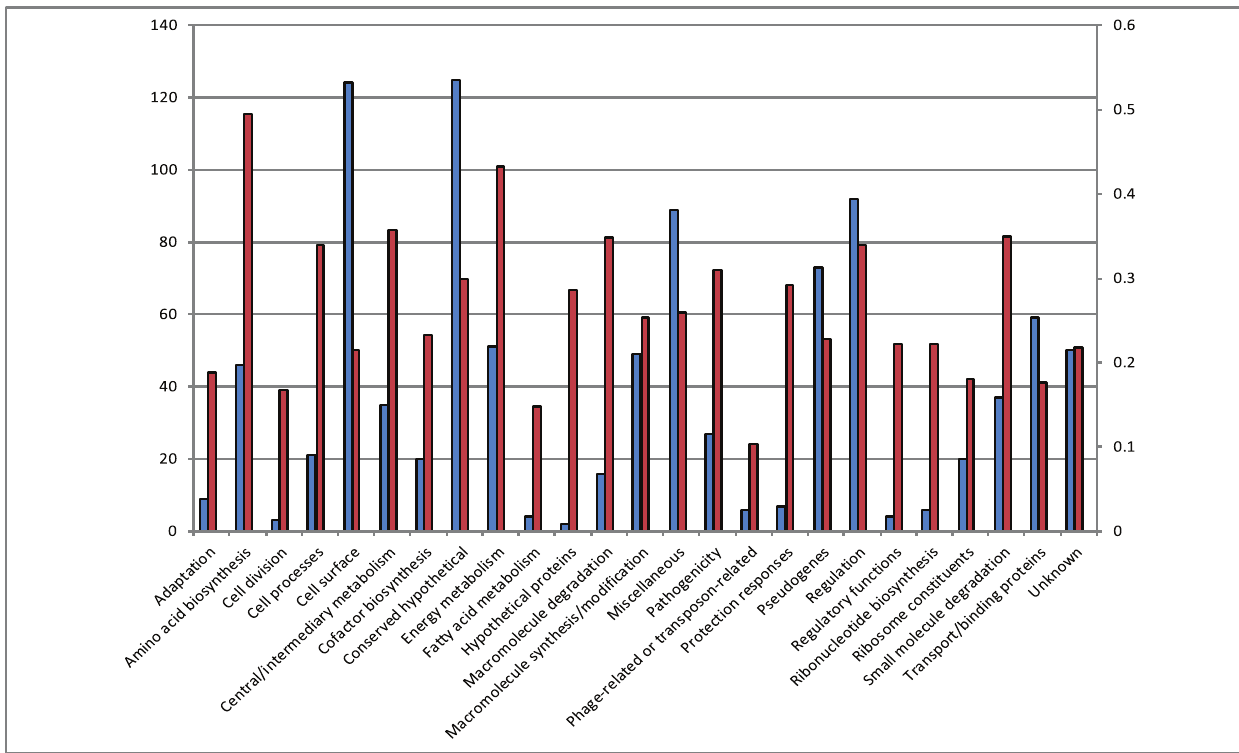
Figure 1. Functional categories of differentially expressed genes between the ptxP1 and ptxP3 strains. The gene count (absolute number of genes) of differentially expressed genes per category (blue). And the gene count of differentially expressed genes relative to the total number of genes (red) present in the genomes of the analyzed strains. doi:10.1371/journal.pone.0066150.g001 PLOS ONE |